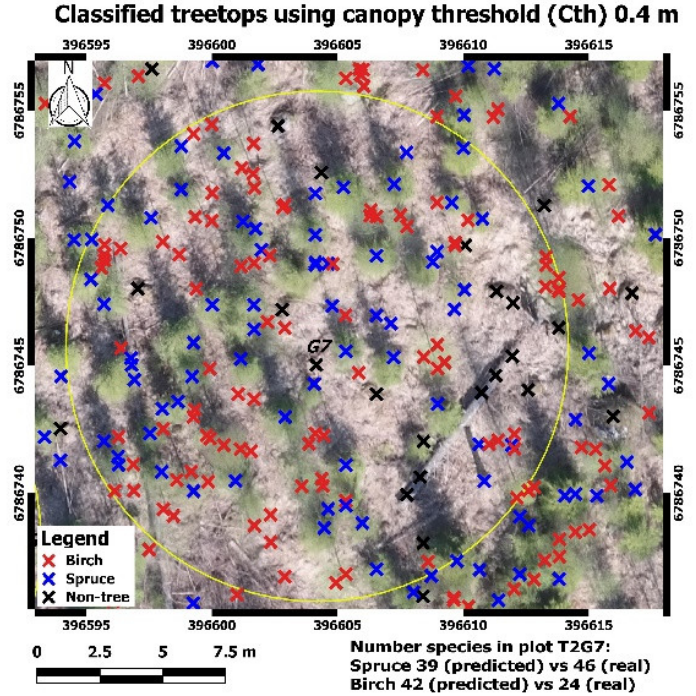
Figure 5. Classified treetops in an advanced seedling plot using leaf-off data in canopy threshold (C th ) of 0.4 m (background is RGB orthomosaic in leaf-off from UAV with resolution of 2.5 cm).